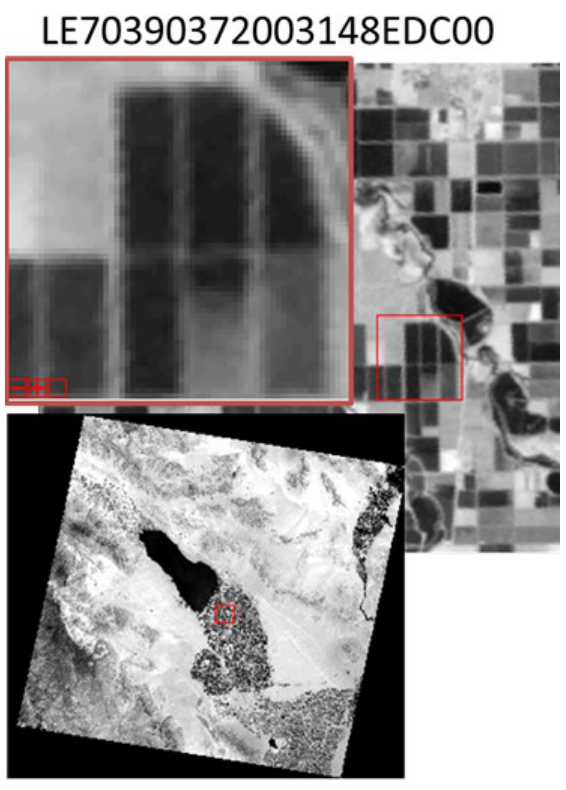
Figure 2. ETM+ thermal band image demonstrating the odd-to-even detector misalignment. The darker features and the jagged edge associated with this feature show the odd-to-even detector misalignment present in the data.